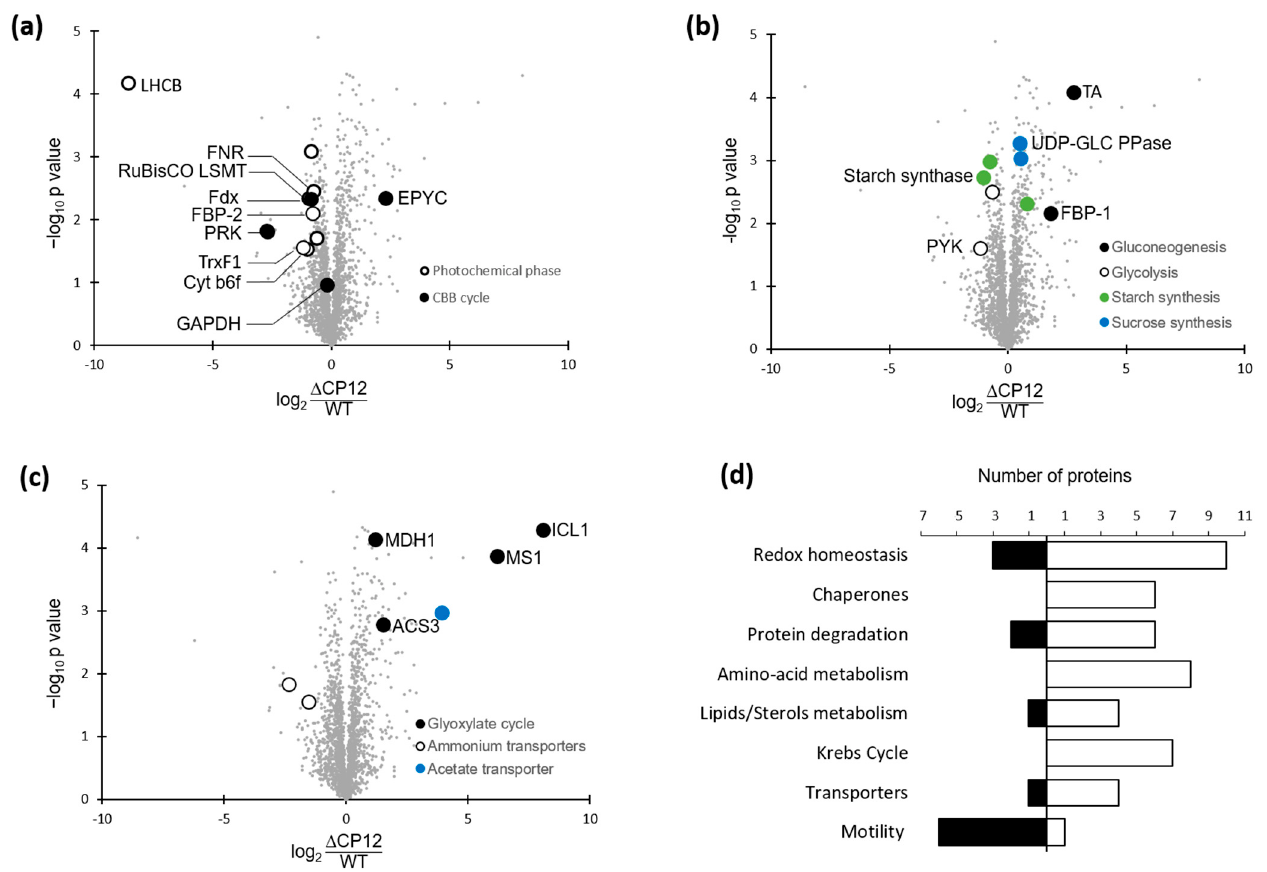
Figure 3. Differentially expressed proteins in ∆ CP12-Cr vs WT-Cr strain. ( a ) Plot highlighting proteins related to photosynthesis metabolic pathways. The plot represents the fold changes in protein abundance. The x-axis shows difference of protein abundance in Δ CP12-Cr vs Wt-Cr (in log 2 ). The y-axis shows the -log 10 p value. The Volcano plot is available in Figure S2. ( b ) Plot highlighting proteins involved in carbohydrates related pathways. ( c ) Plot highlighting other metabolic pathways. ( d ) Number of proteins increasing or decreasing in abundance in ∆ CP12-Cr strain, classified by selected metabolic pathways. The proteins that are more abundant in ∆ CP12-Cr compared to WT-Cr are counted in the white bars, the proteins that are less abundant are counted in the dark bars. All the metabolic pathways are shown in Figure S3. LHCB, light-harvesting chlorophyll a/b-binding; FNR, Ferredoxin NADP + Reductase; RuBisCO LSMT, RuBisCO large subunit methyltransferase; Fdx, ferredoxin; FBP, Fructose-1,6-bisphosphatase; TrxF1, Thioredoxin F1; Cyt b6 f, Cytochrome b6 f complex; EPYC, essential pyrenoid component 1; TA, transaldolase; UDP-GLC PPase, UDP-glucose pyrophosphorylase; PYK, pyruvate kinase; ICL1, Isocitrate Lyase 1; MS1, Malate synthase 1; MDH1, Malate dehydrogenase 1; ACS3, Acetyl-CoA synthetase 3.